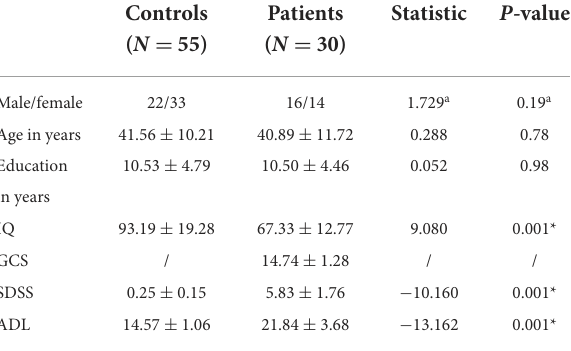
TABLE 2 The relationships between channels and brain areas.